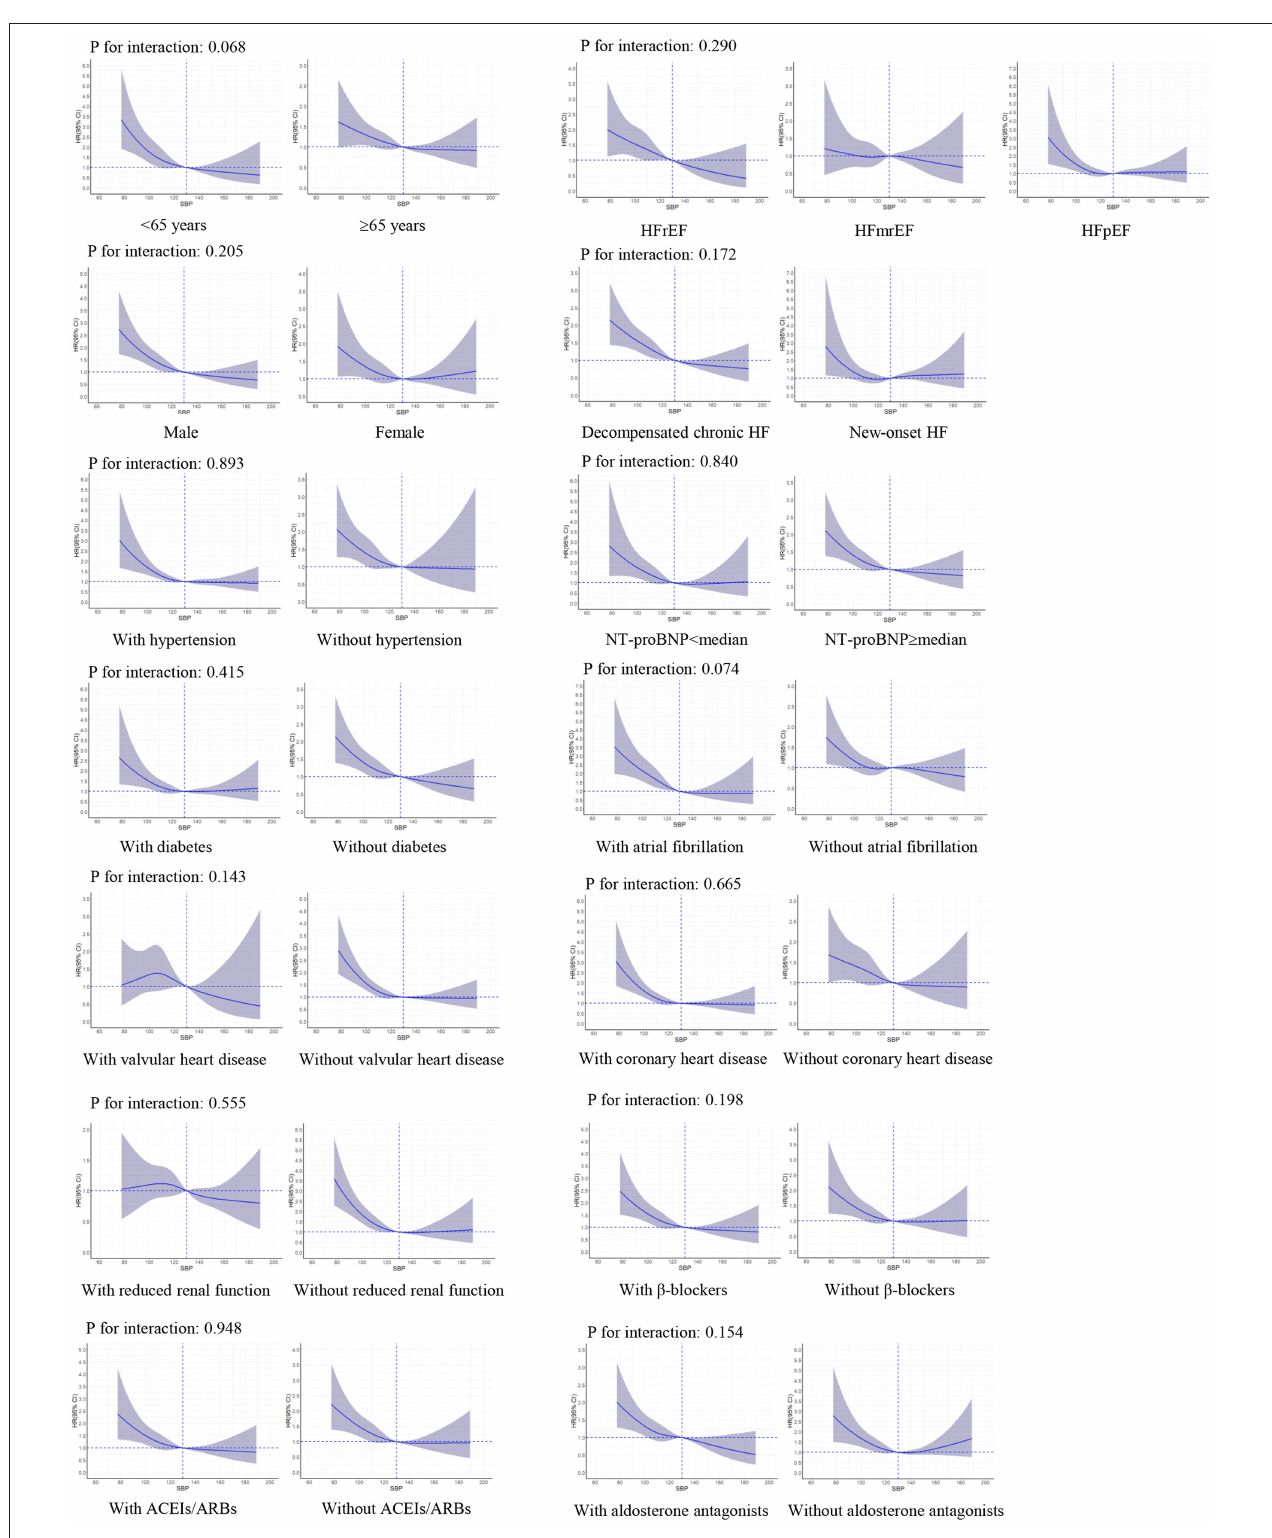
FIGURE 3 | Restricted cubic spline curves for an association between systolic blood pressure and all-cause death in subgroups. SBP of 130 mmHg was applied as the reference. ACEIs, angiotensin-converting enzyme inhibitors; ARBs, angiotensin II receptor blockers; CI, confidence interval; HR, hazard ratio; HF, heart failure; HFrEF, heart failure with reduced ejection fraction; HFmrEF, heart failure with mid-range ejection fraction; HFpEF, heart failure with preserved ejection fraction; NT-proBNP, N-terminal pro-brain natriuretic peptide; SBP, systolic blood pressure.